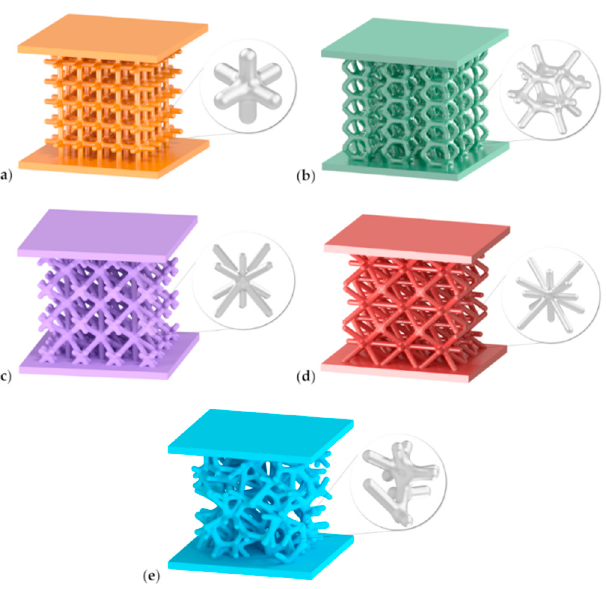
Figure 1. Lattice structures designed in Autodesk Netfabb 2021, with the following topology: ( a ) Grid; ( b ) Hexagon; ( c ) Star; ( d ) Tetra; ( e ) Trabecular, together with enlarged beam-like shapes. Each of them consisted of interconnected beams with circular cross-sections of equal nominal diameters: 1.5 mm. In addition, two flat faceplates, top and bottom, were